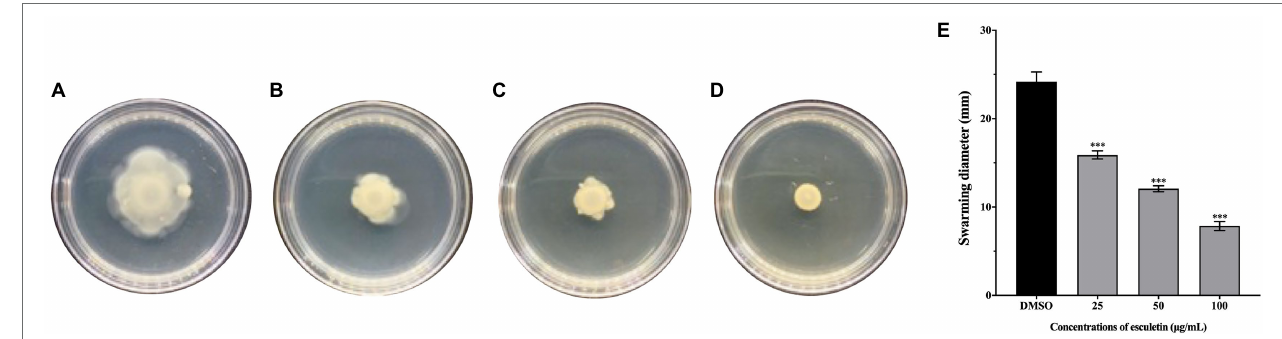
FIGURE 4 | Effect of esculetin at sub-MICs (25, 50, and 100 μ g/ml) on swarming motility of A. hydrophila SHAe 115. (A) DMSO, (B) 25 μ g/ml, (C) 50 μ g/ml, (D) 100 μ g/ml, (E) Swarming zone diameter. Data are presented as the swarming diameter of mean ± SD of three independent experiments. *** p < 0.001 compared to the DMSO control group by one-way